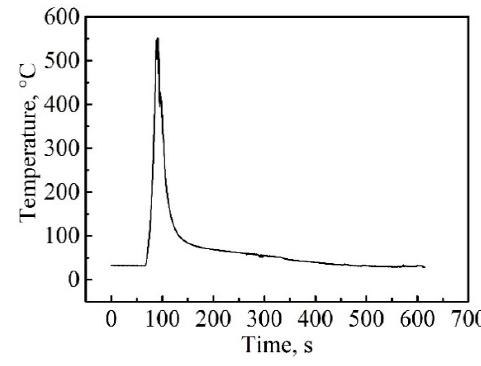
Figure 6. Relationship between welding temperature and time.